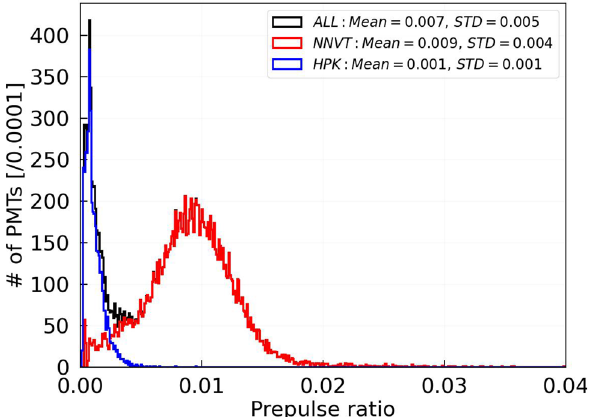
Fig. 28 Pre-pulse ratio of all qualified PMTs. Black: all PMTs; red: NNVT PMTs; blue: HPK PMTs